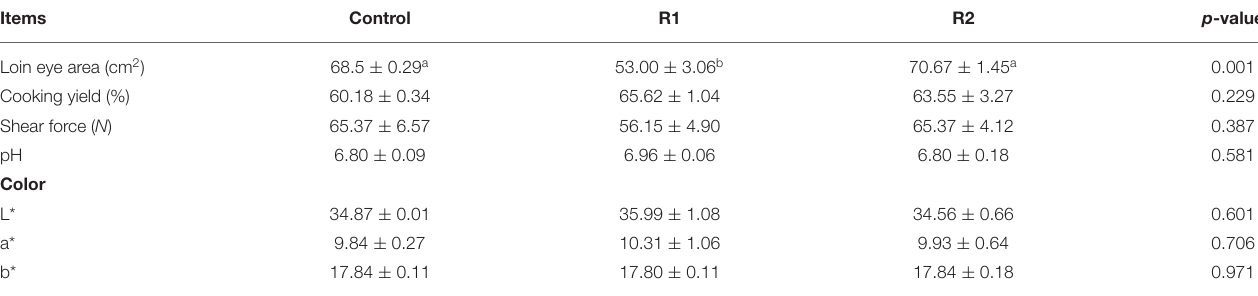
TABLE 3 | Effects of different dietary levels of fermented-Moutai distillers’ grain (FMDG) on the meat quality of Guanling cattle.